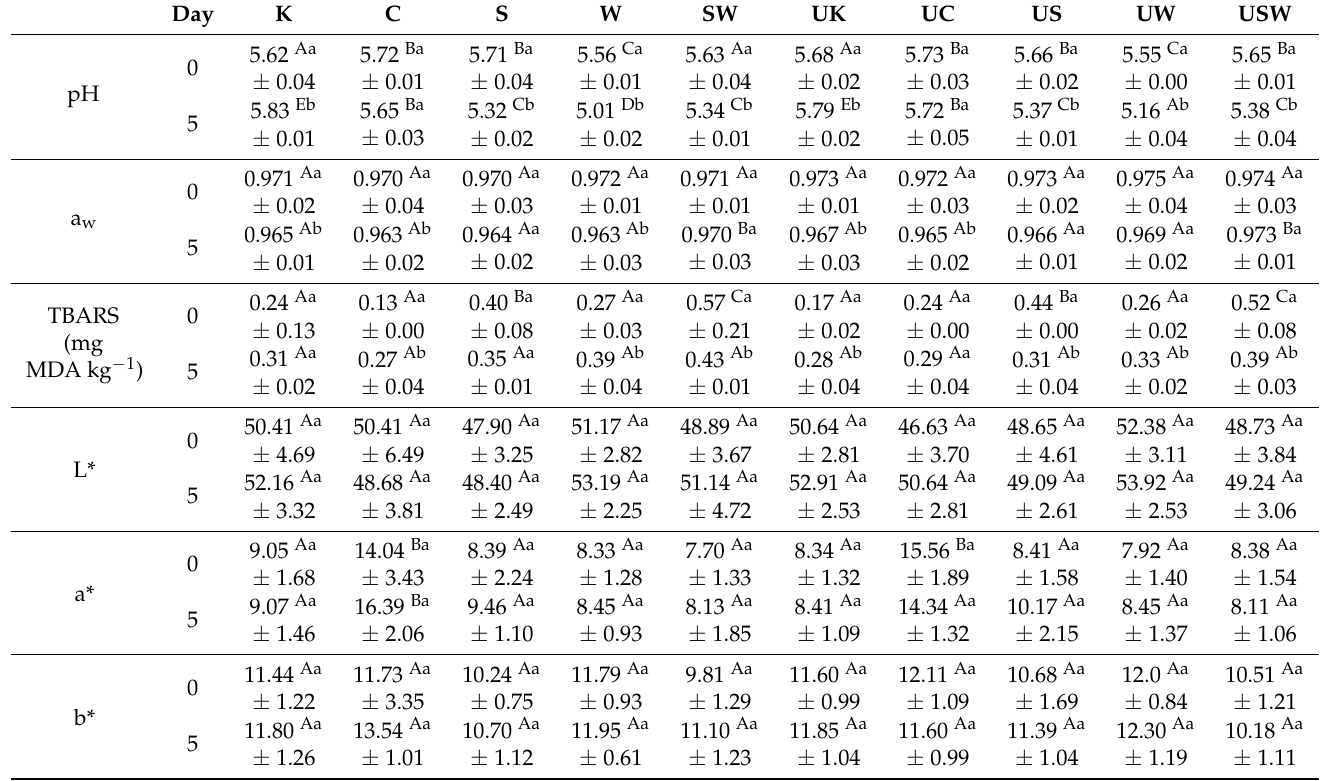
Table 4. Acidity, lipid oxidation, water activity, and color parameters of lamb stuffing (mean ± standard deviation) before and after 5-day storage (mean ± standard